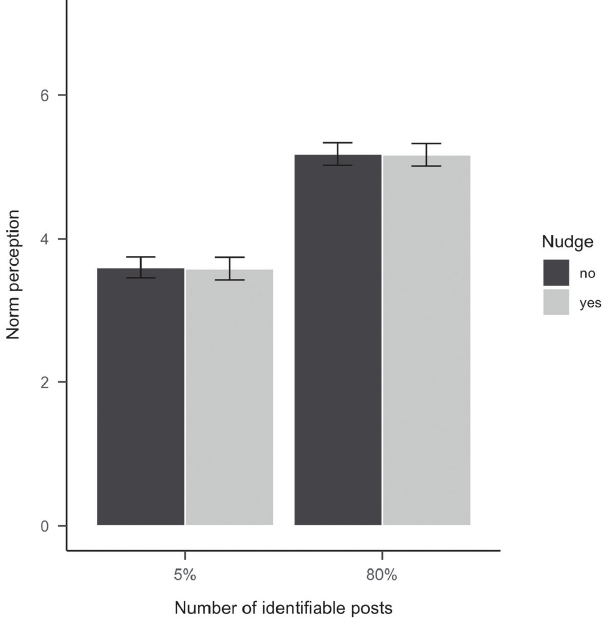
Fig 5. The effect of number of identifiable profile pictures and number of identifiable posts on norm perceptions in Study 2. Bars represent estimated marginal means. The error bars represent 95% confidence intervals.